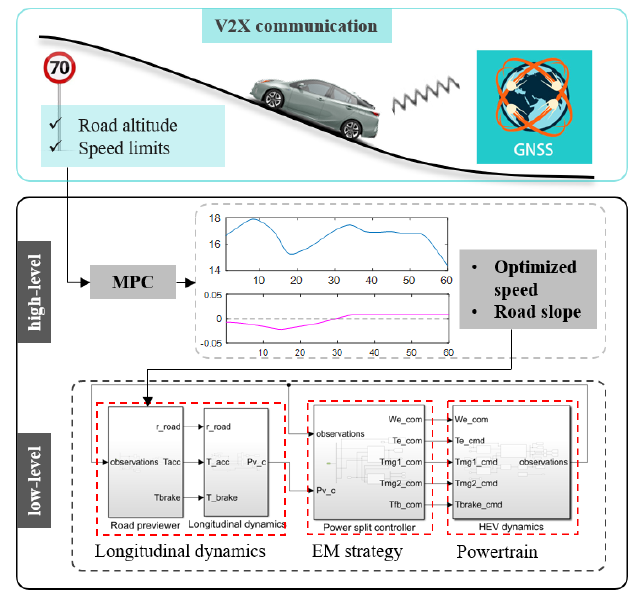
Figure 3. Hierarchical EC.